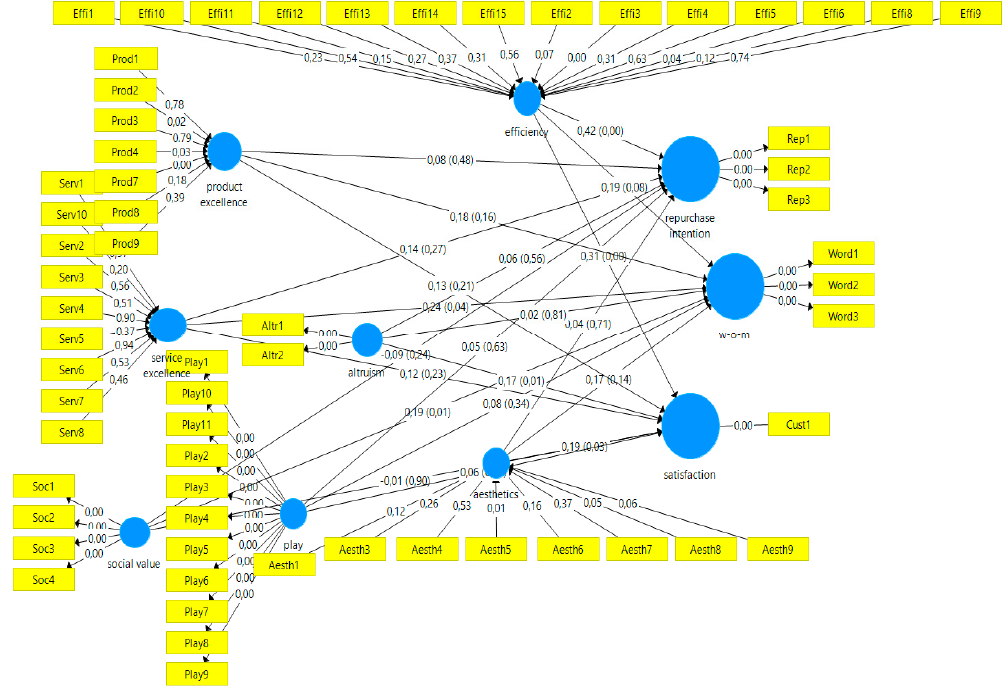
Figure 2. Final model.